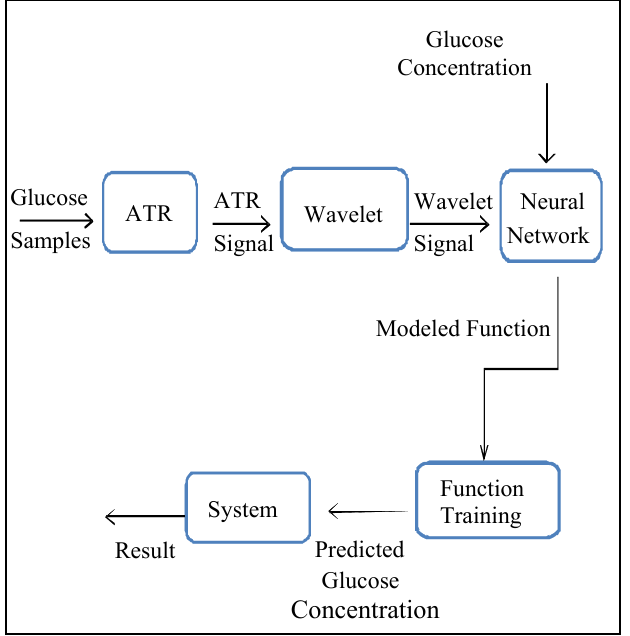
Figure 3. Architecture of data analysis and